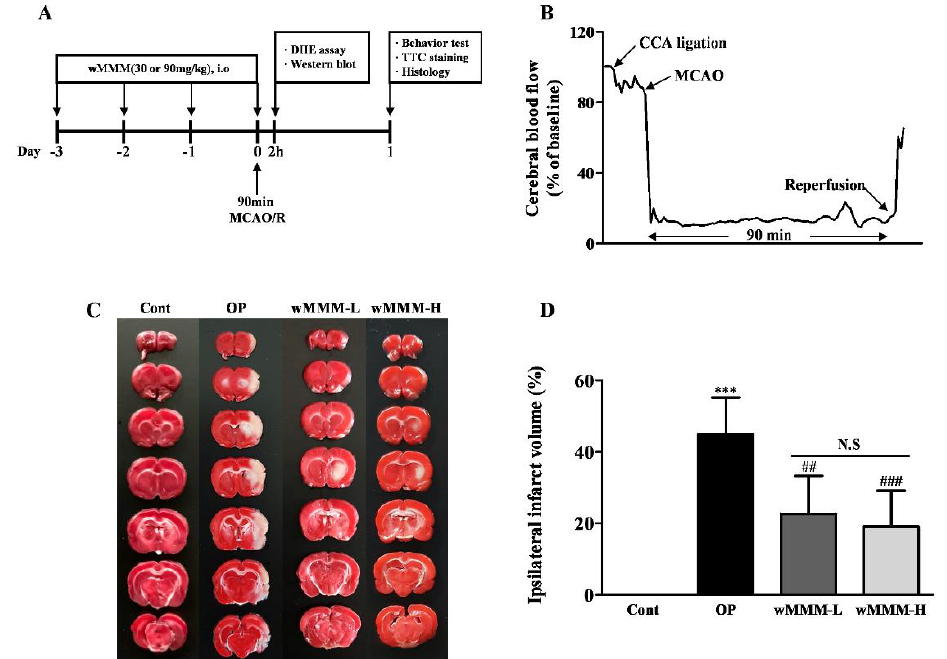
Figure 4. Reduction in infarct volume in in vivo focal cerebral ischemia (fCI) rat models by water- mixed mushroom mycelia (wMMM) administration. Time flow of the in vivo experimental schedule ( A ) and representative doppler flowmetry ( B ) showing changes in relative cerebral blood flow during the entire MCAO/R procedure. The details are presented in the Materials and Methods section. Representative photographs of 2,3,5-triphenyltetrazolium chloride-stained coronal brain sections ( C